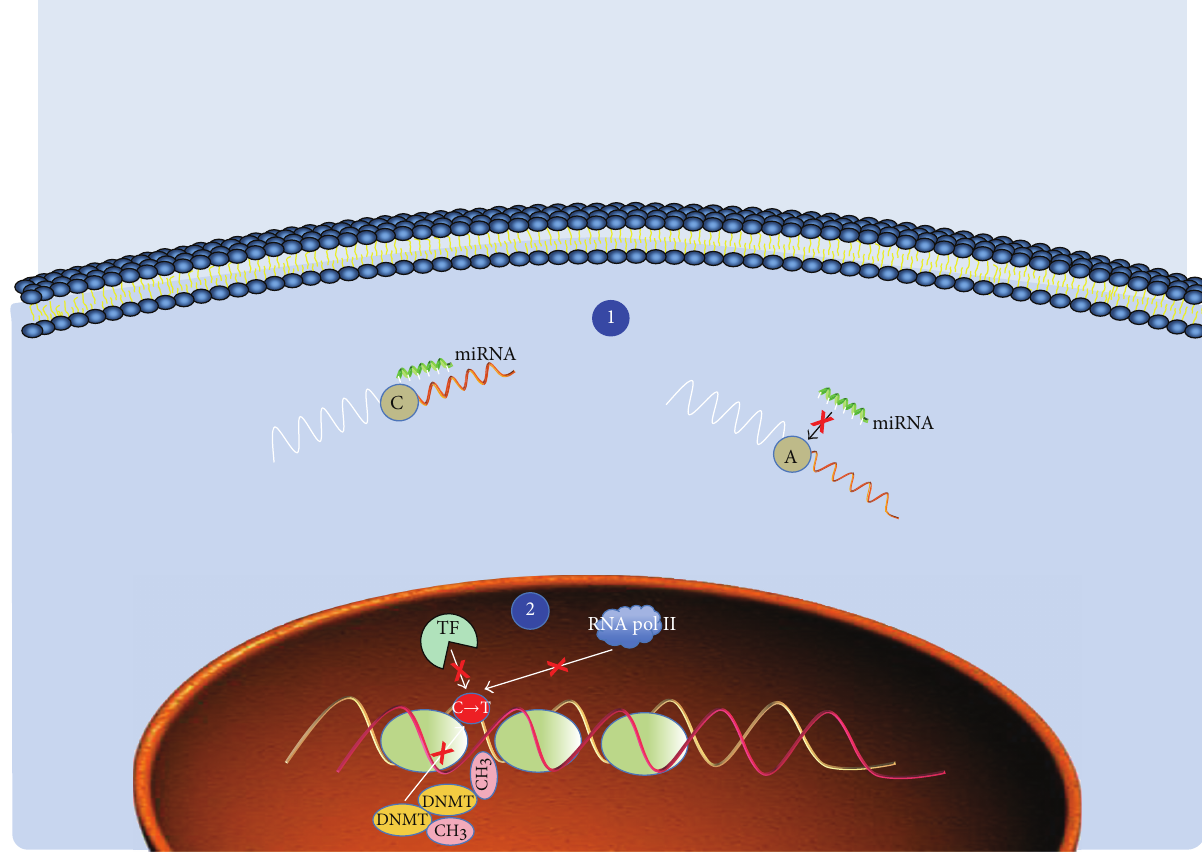
Figure 3: SNPs affecting gene expression and epigenetic mechanism. Schematic representation of how SNPs can potentially affect different processes. (1) A single nucleotide variation (e.g., C to A substitution) may prevent miRNA from binding to its target site in the 3 󸀠 untranslated region (UTR) of a gene. (2) SNP may also abrogate the binding site of a transcription factor (TF) and/or the binding of proteins involved in = methyl group.; RNA pol II = RNA transcription as well as in chromatine remodelling. DNMT = DNA methyltranferase; CH 3